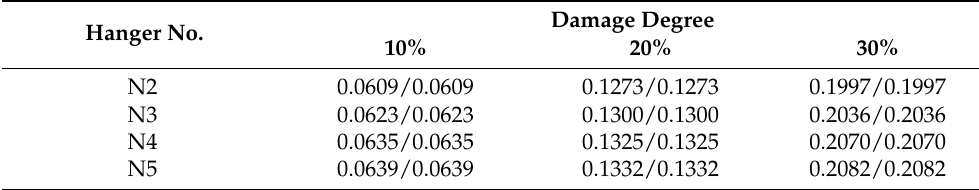
Table 2. Actual cable force reduction ratio and identification results (one hanger damaged alone).